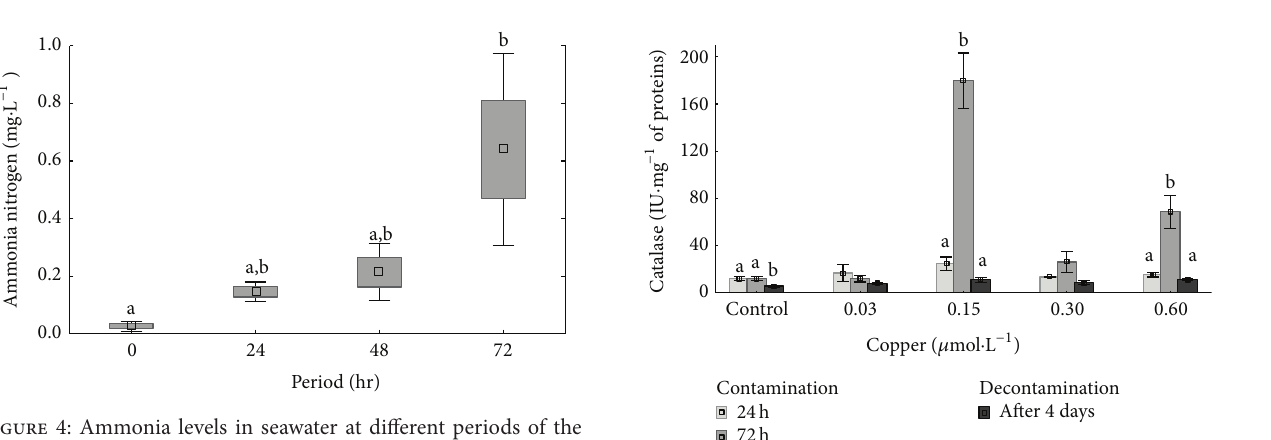
Figure 4: Ammonia levels in seawater at different periods of the experiment. Different letters show means with significant differ- ences ( 𝑃 < 0.05 ). Figure 5: CAT activity at 24 h, at 72 h, and after 4 days in the gills of the mussel Perna perna under copper exposure . In each group, the means with different letters have significant differences ( 𝑃 < 0.05